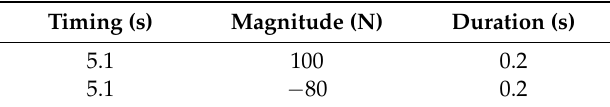
Table 5. Impact forces applied in Test 1 and Test 2.